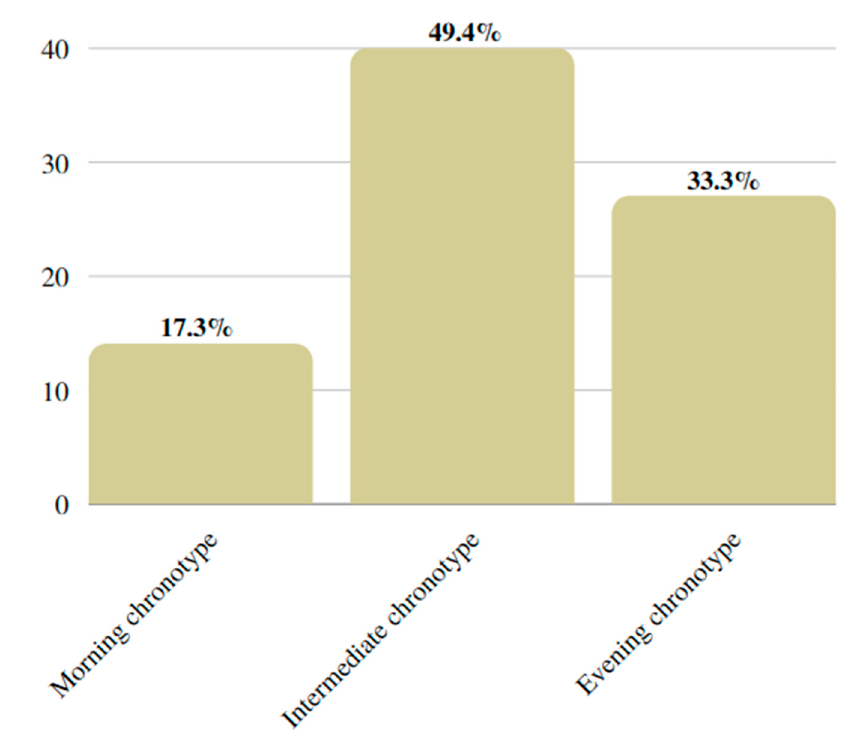
Nutrients 2023 , 15 , x FOR PEER REVIEW Figure 1. Study population divided into chronotype categories. Figure 1. Study population divided into chronotype categories.